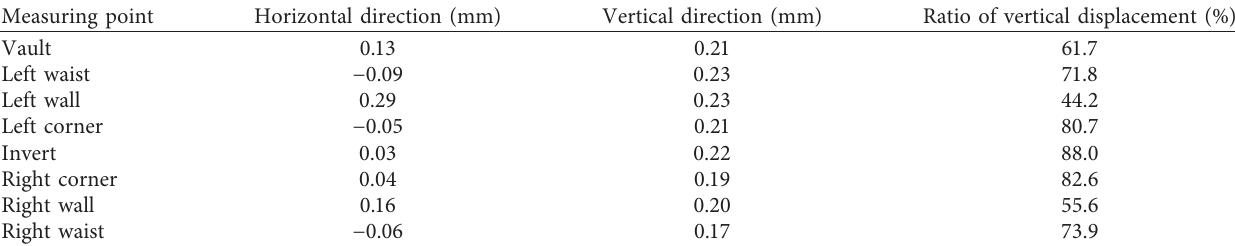
Table 8: Additional deformation of the right-line mining tunnel structure induced by left-line shield tunnelling.